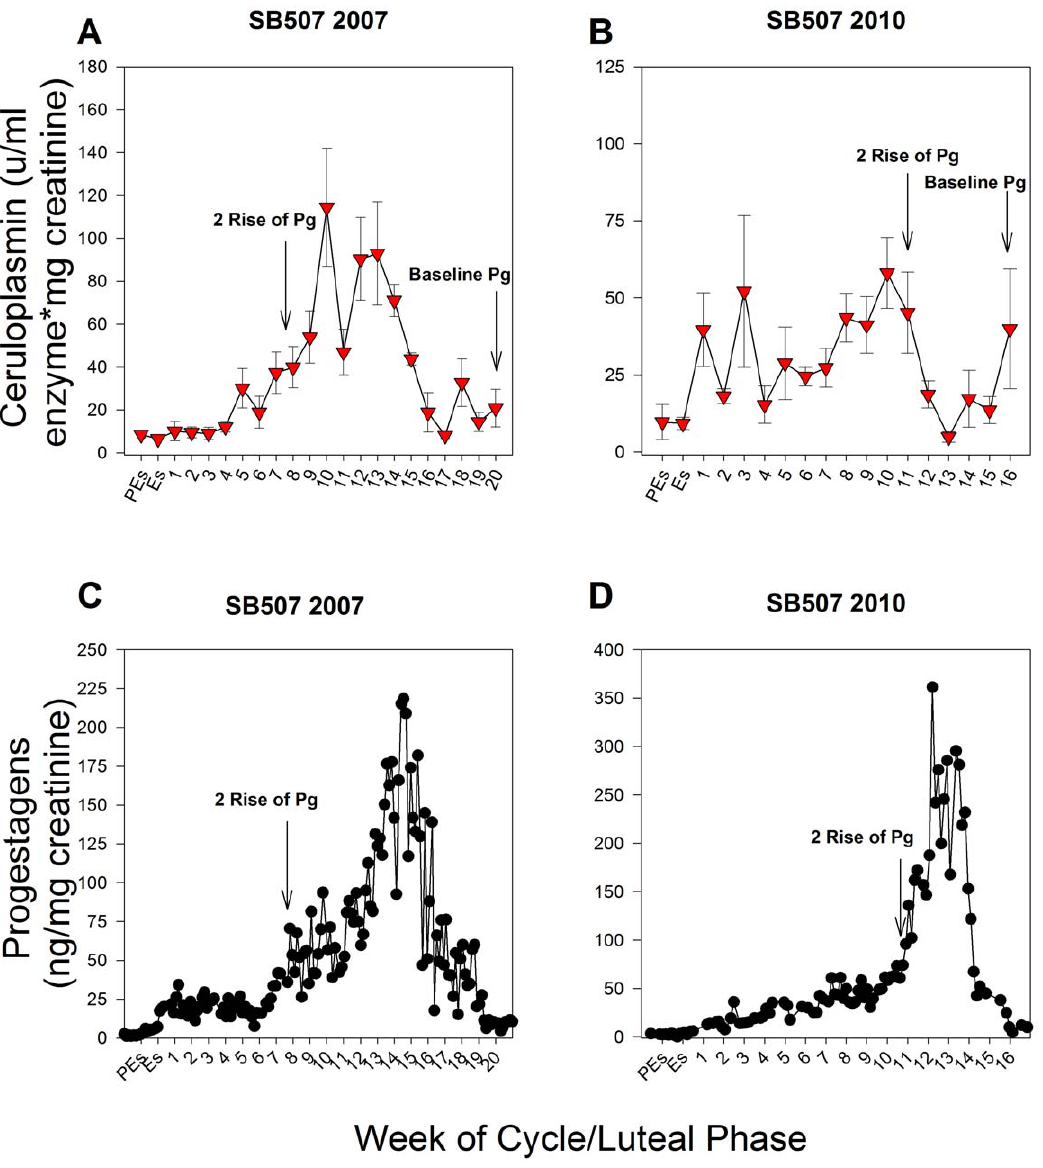
Figure 4. The levels of active urinary ceruloplasmin and urinary progestagens in lost pregnancies for female SB507. SB507 (MZS) was confirmed pregnant after artificial insemination in 2007 and 2010 by ultrasound at weeks 18 and 13, respectively; however, retarded growth was observed by ultrasound in the weeks thereafter and no birth occurred in either year. The levels of active urinary ceruloplasmin in 2007 (4A) and 2010 (4B) for SB507. Panels 4C and D: The levels of urinary progestagens in 2007 (4C) and 2010 (4D) for SB507. Red diamonds represent the levels active urinary ceruloplasmin; Black circles represent urinary progestagen concentrations; Pg=Progestagen; Pg=Progestagen; PEs=Proestrus; Es=Estrus; Numerical numbers=weeks of the luteal phase. Variations in the x and y axes exist to accommodate variable concentrations and durations. Data are weekly means 6 SEM; n=2 reproductive cycles.